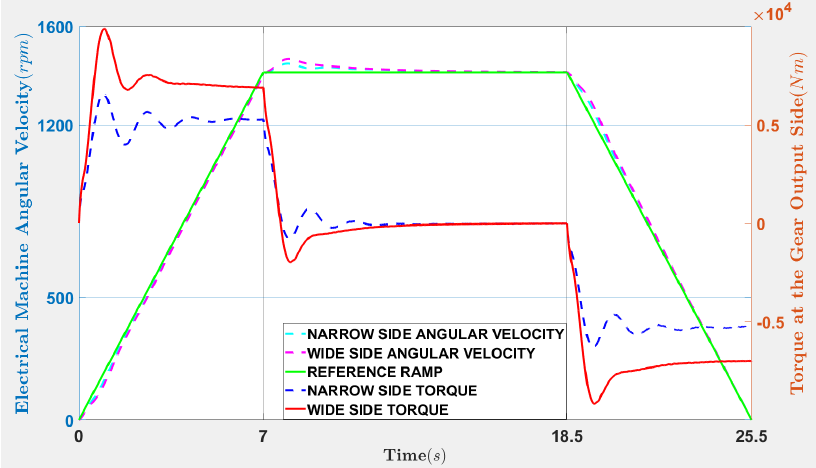
Figure 7. Electrical Machine Angular Velocity and Torque at the Gear Output